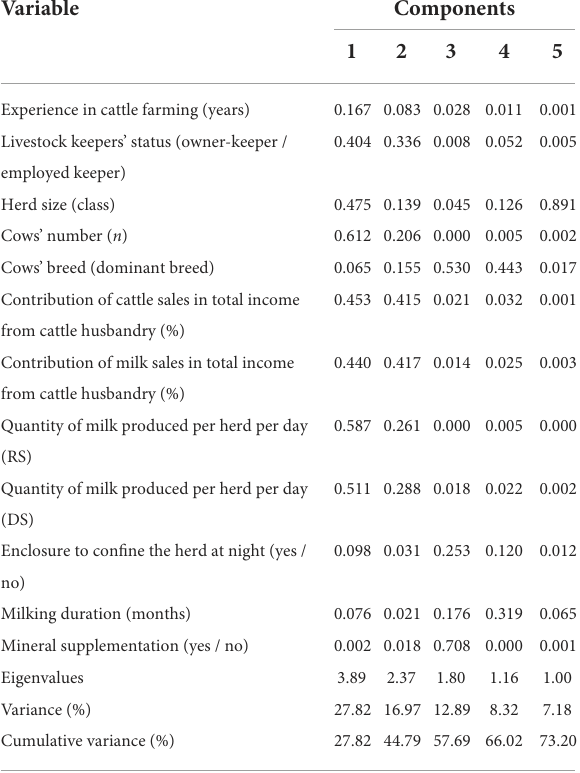
TABLE 4 Factor loadings obtained in the factor analysis of mixed data (FAMD).